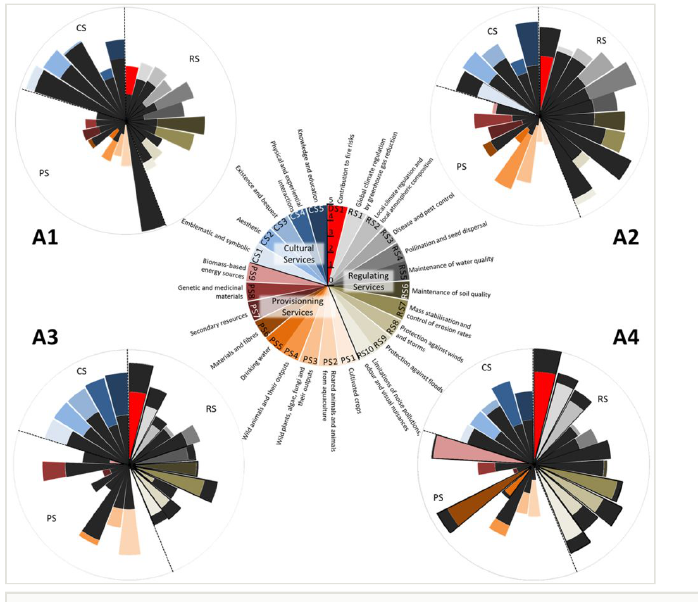
Bundles of ES capacity of the potential Life action